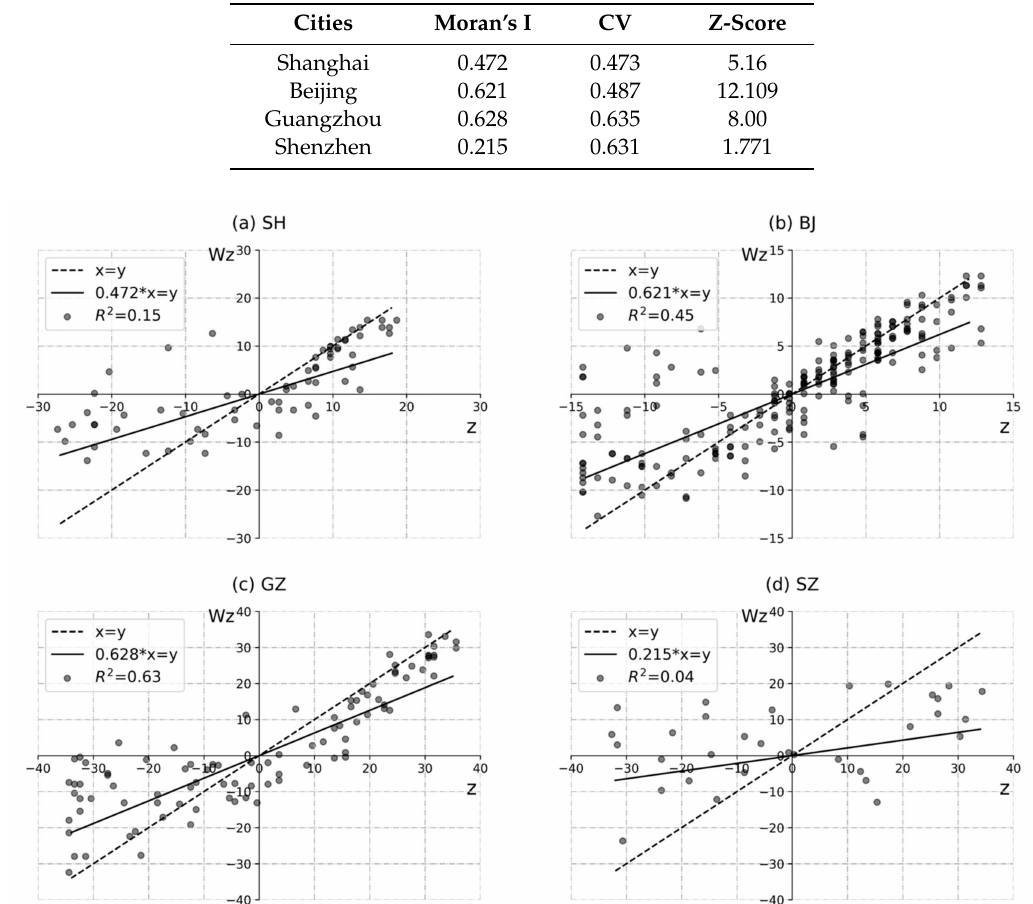
Table 3. The results of Moran’s I and CV in four study cities.